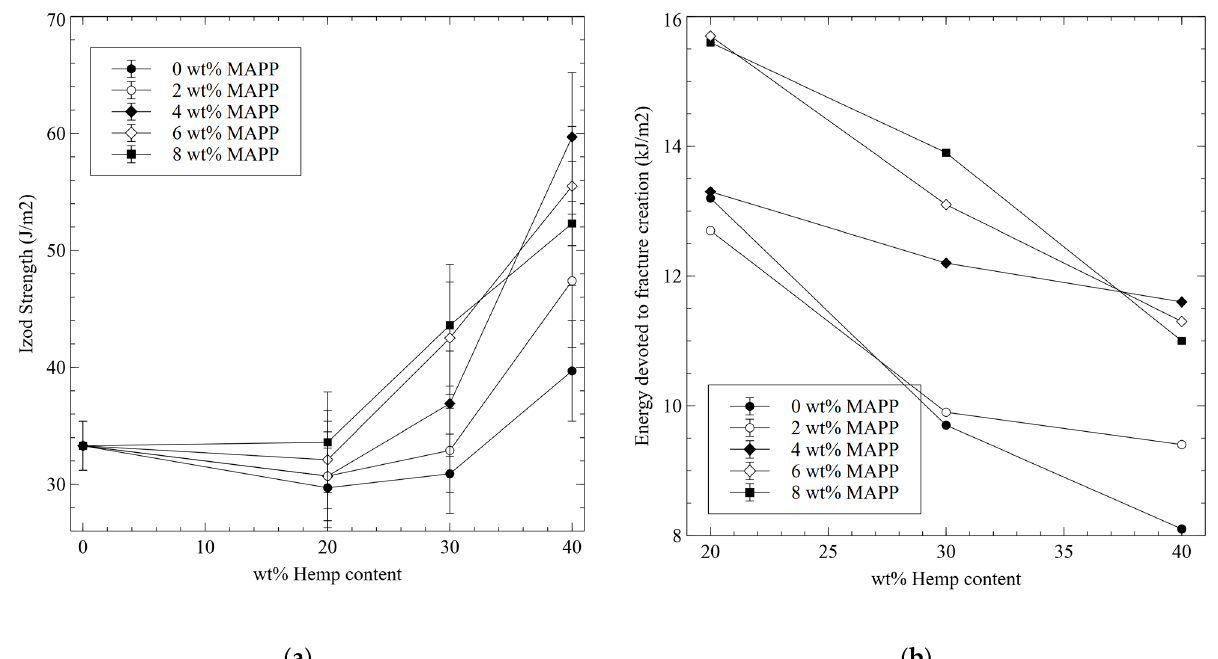
Figure 3. ( a ) Evolution of the impact strength for notched Charpy specimens against MAPP and HS contents; ( b ) Estimation of the evolution of the energy needed to create a critical fracture against MAPP and HS contents.